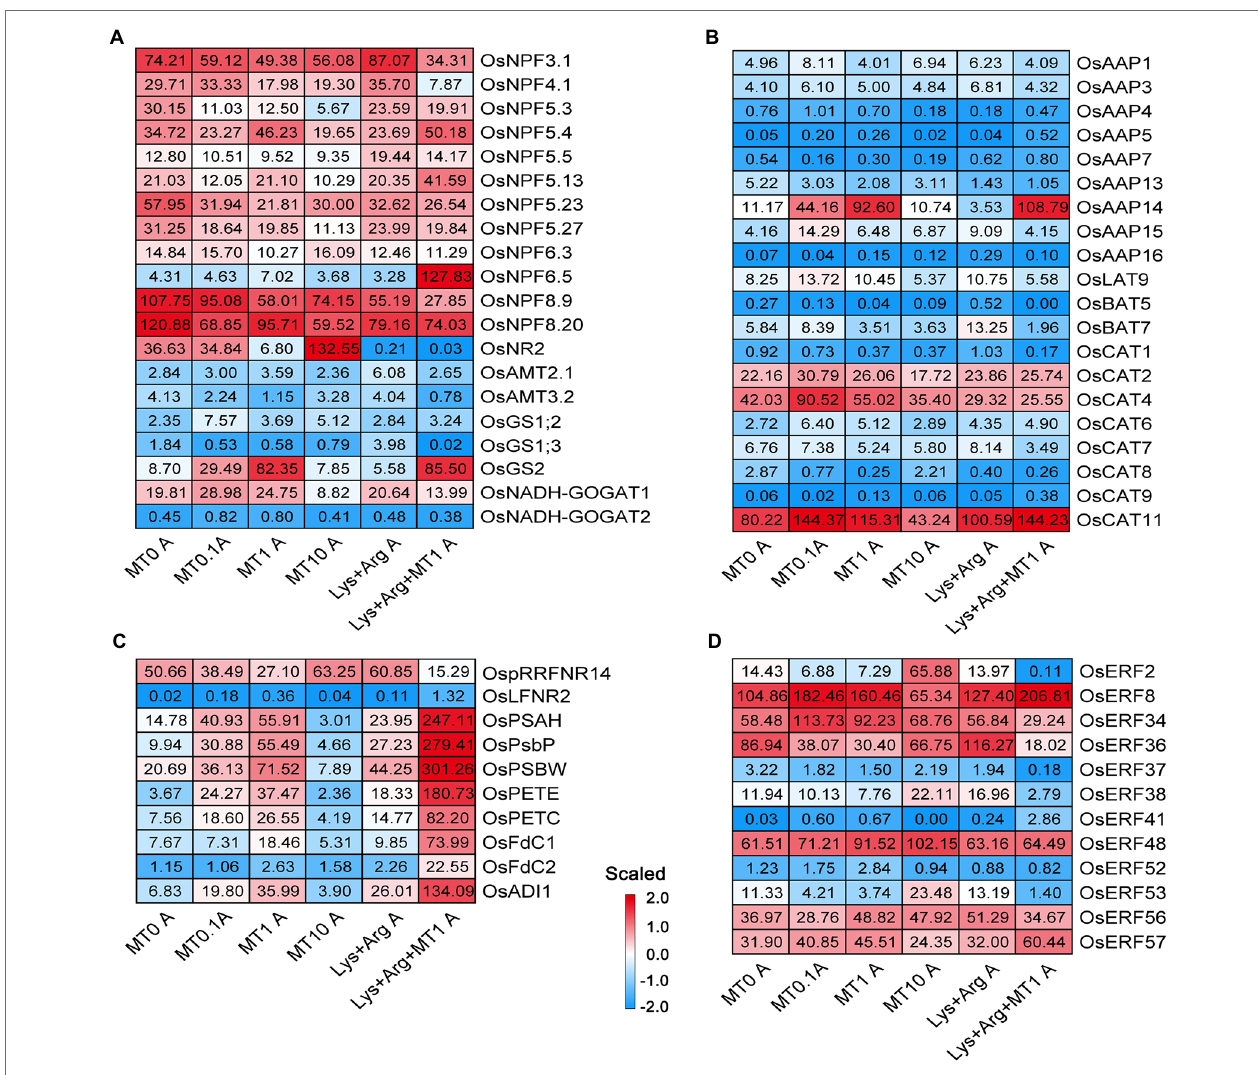
FIGURE 4 | The expression of genes involved in nitrogen metabolism, photosynthesis and stress in axillary bud under different concentrations of melatonin and amino acids. Heatmaps display the expression patterns of genes involved in nitrate and ammonium transport and assimilation (A) , amino acid transport (B) , photosynthesis (C) and stress (D) . Red and blue represent the highest and lowest level of expression. MT represents melatonin, Lys represents lysine, and Arg represents arginine. A at the bottom of each graph represents axillary bud, and B at the bottom of each graph represents basal part. MT0, MT0.1, MT1 and MT10 represents melatonin at 0 μ m, 0.1 μ m, 1 μ m and 10 μ m,